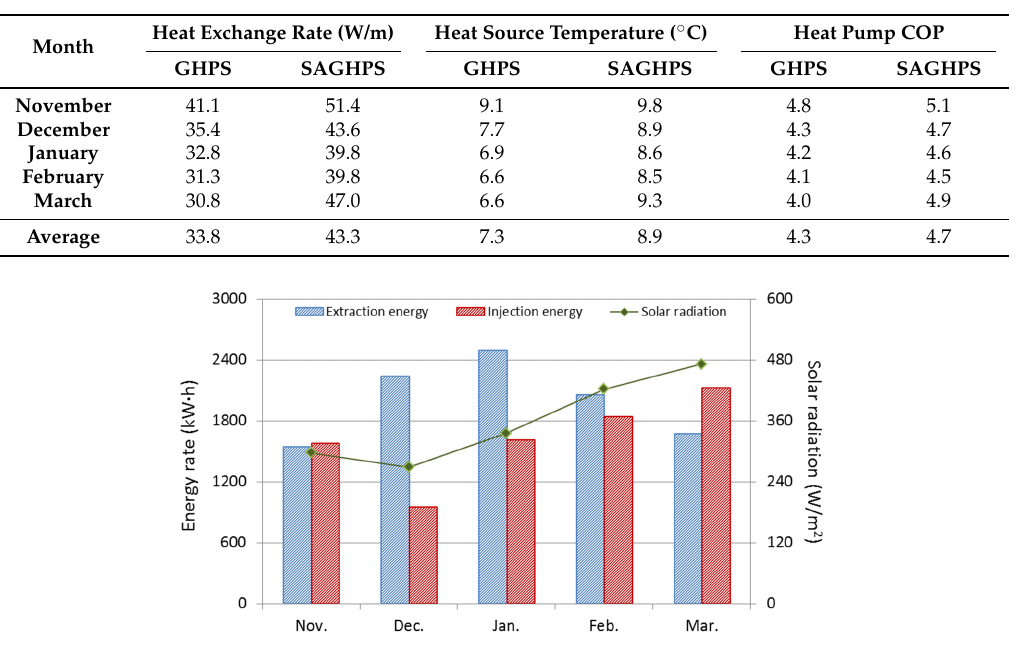
Figure 9. Simulation result of energy rate and solar radiation.